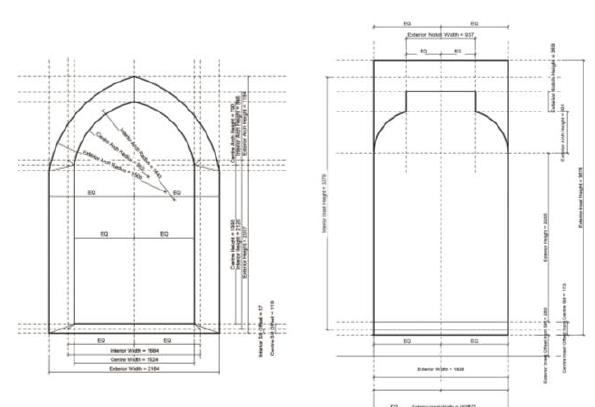
Figure 2. Reference planes and all associated parameters of two generic opening families. The family on the left can be used to produce all of the round-headed and pointed arch opening types, the family on the right can be used to produce all of the square-headed trefoil opening types.